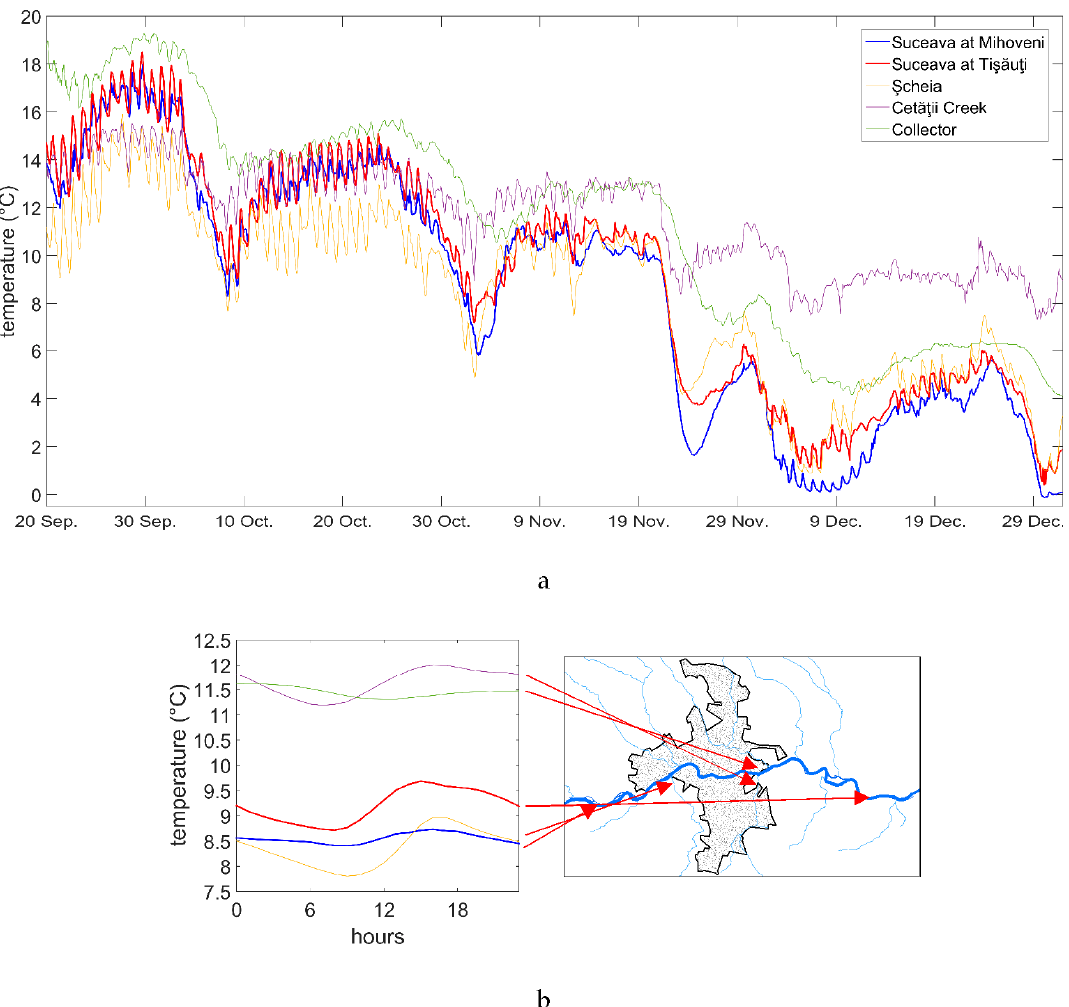
Figure 10. Comparisons of water temperature of Suceava River and its urban tributaries during September 20–December 31, 2019: ( a ) temporal evolution of hourly data, ( b ) average diurnal profiles of water temperature.